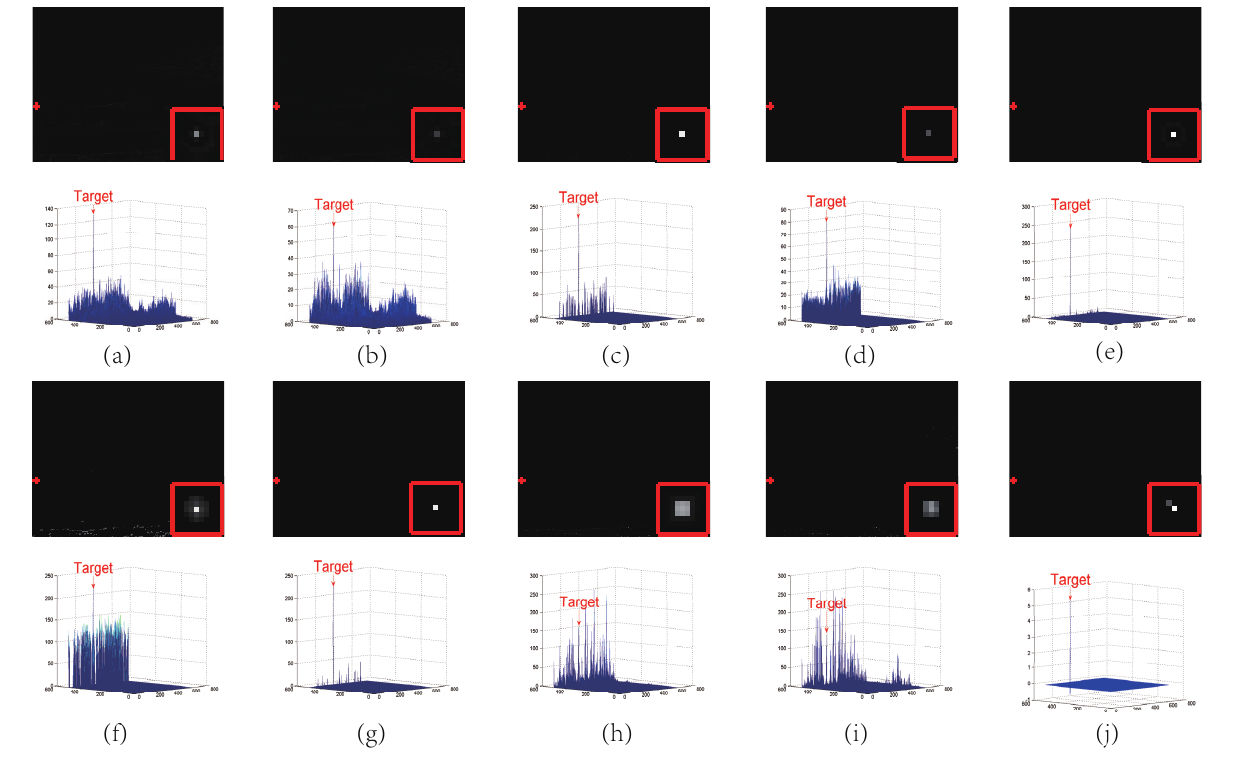
Figure 9. ( a – j ): Top hat, ANI, PSTNN, ASTTV, GST, NTFRA, NRAM, HB-MLCM, ADMD, and the proposed method’s difference diagram and three-dimensional diagram in scene E, respectively.